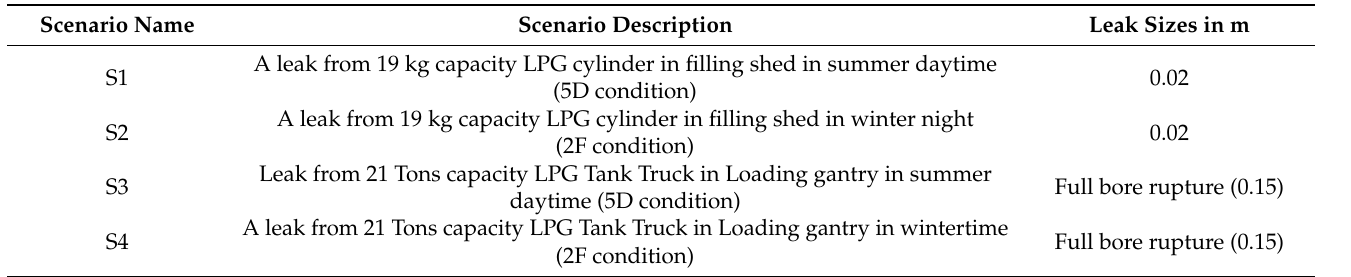
Table 1. The list of worst-case scenarios considered for the LPG